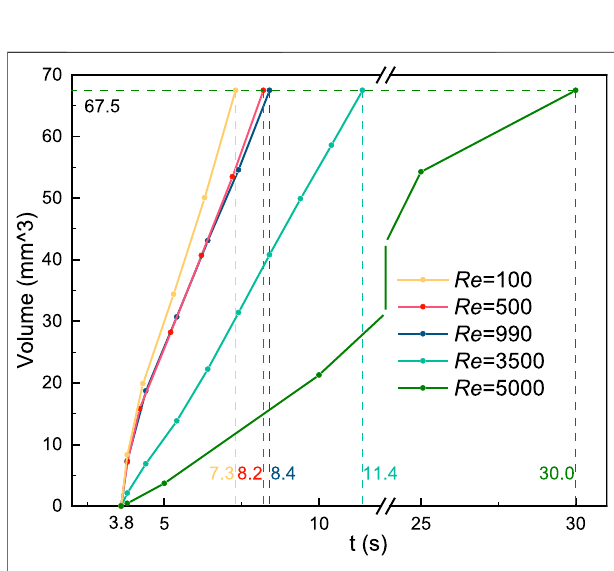
FIGURE 7 | Relationship between the thrombus volume and simulation time. Blood fl ow with a low Reynolds number would accelerate the thrombus formation. On the contrary, the thrombosis process would be slowed by high Reynolds number and turbulence. The vertical dashed line indicates the respective computational time and the horizontal line is the fi nal thrombus